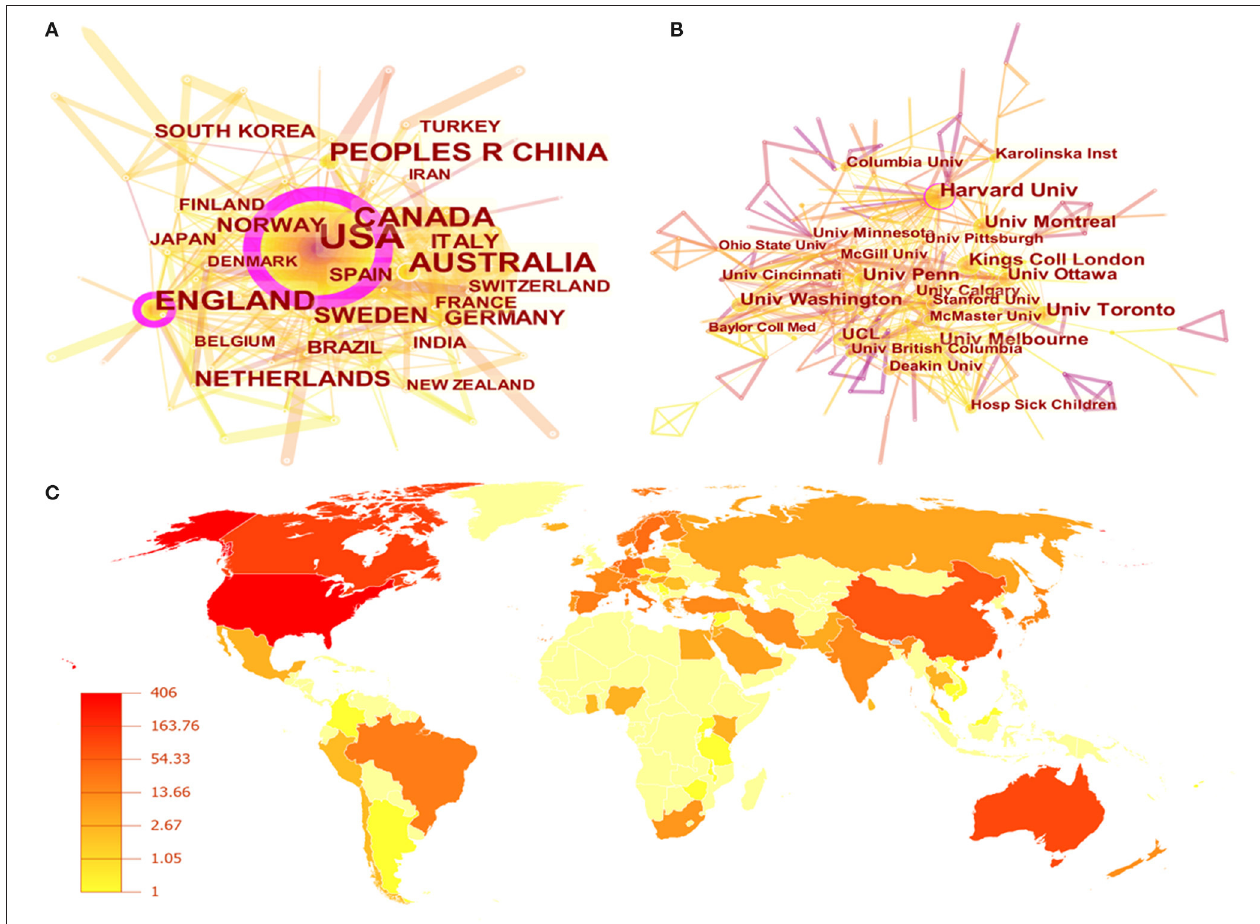
FIGURE 2 | The collaboration of countries and institutions. (A) Map of countries with publications in exercise-depression-teenager research. (B) Map of institutions with publications in exercise-depression-teenager research. (C) The distribution of countries/regions engaged in exercise-depression-teenager research. co-citation counts, which represented that these journals